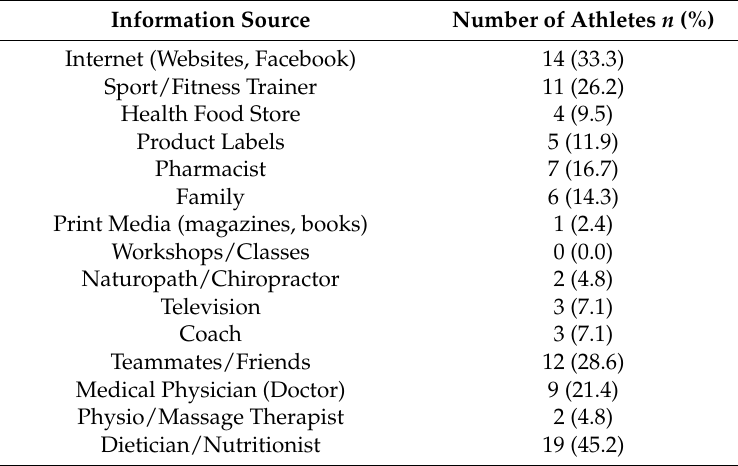
Table 4. Information Sources for Dietary